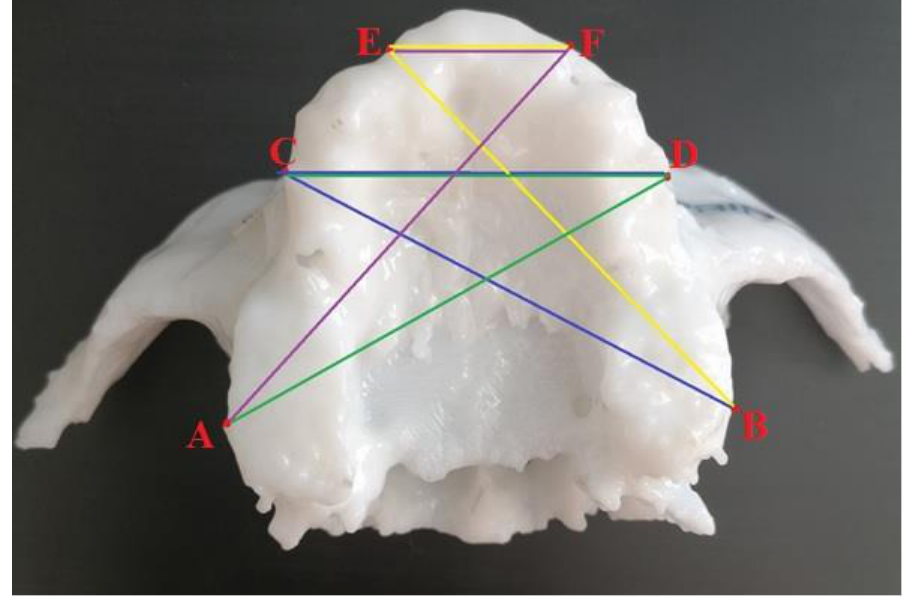
Figure 1. Points for craniometric measurements on the maxillary alveolar processes (A – F).